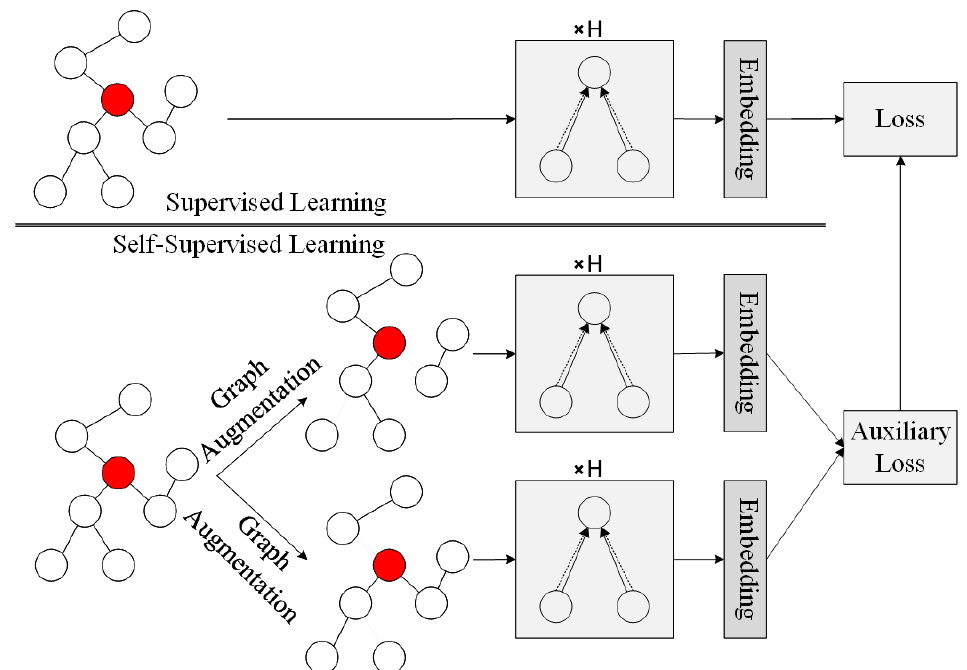
Figure 1. Overall framework. The upper part is for the supervised task, and an H-graph attention network does feature extraction with multiple lines in the network representing a multi-headed atten- tion mechanism; the lower part is self-supervised learning as an auxiliary task, sharing parameters with the network layer in the supervised